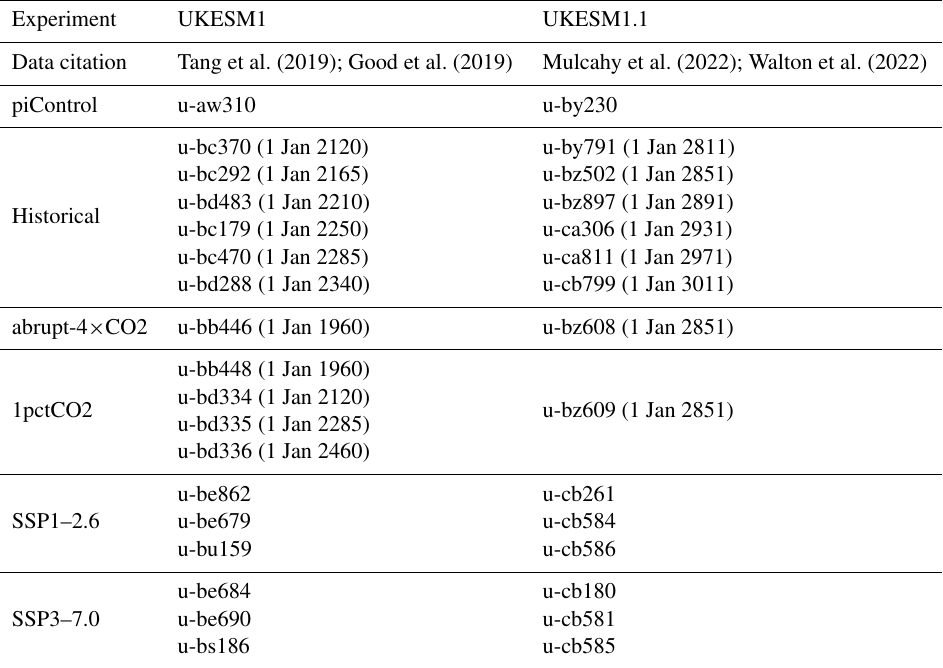
Table A1. Summary of the simulation identifiers used in this study. The branch dates of the piControl simulation are shown in parentheses. The SSPs were branched off of the first three historical simulations listed. Data citations for the model data are also provided.